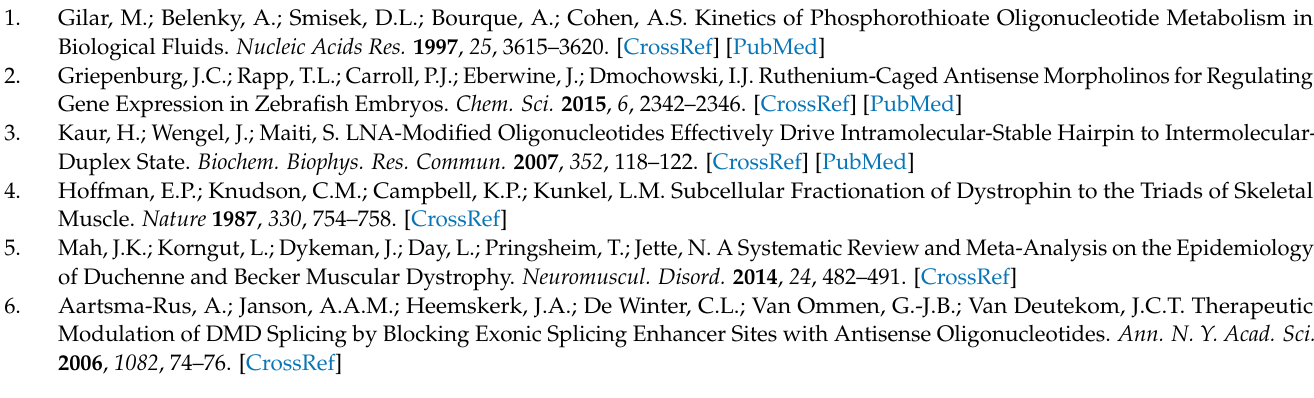
Figure S3: In situ biodistribution of PMO and tcDNA following single ICV administration; Figure S4: Comparison of single and repeated ICV delivery of tcDNA in hDMD mice; Figure S5: Biodistribution of ASO following ICM delivery; Figure S6: Comparison of various delivery routes for tcDNA and PMO; Figure S7: Summary of exon skipping efficacy following various delivery routes for tcDNA and